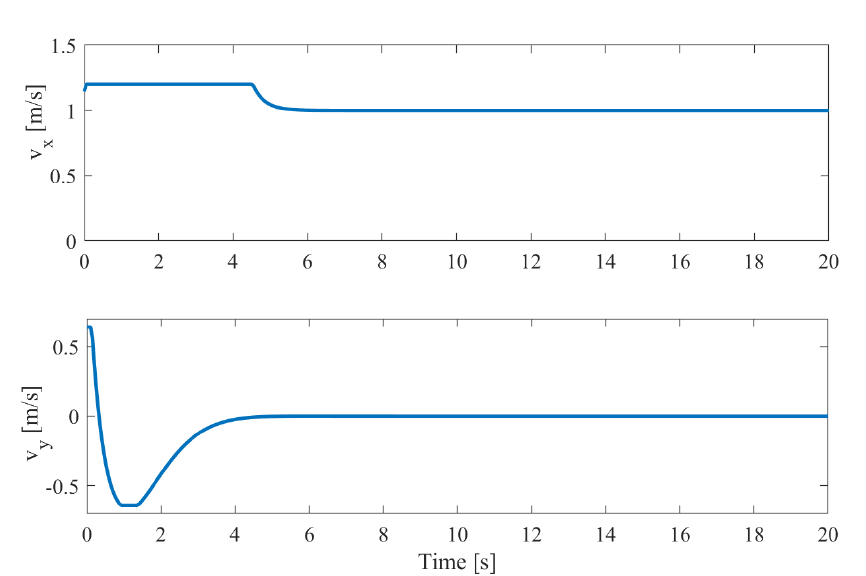
Figure 11. Longitudinal velocity and lateral